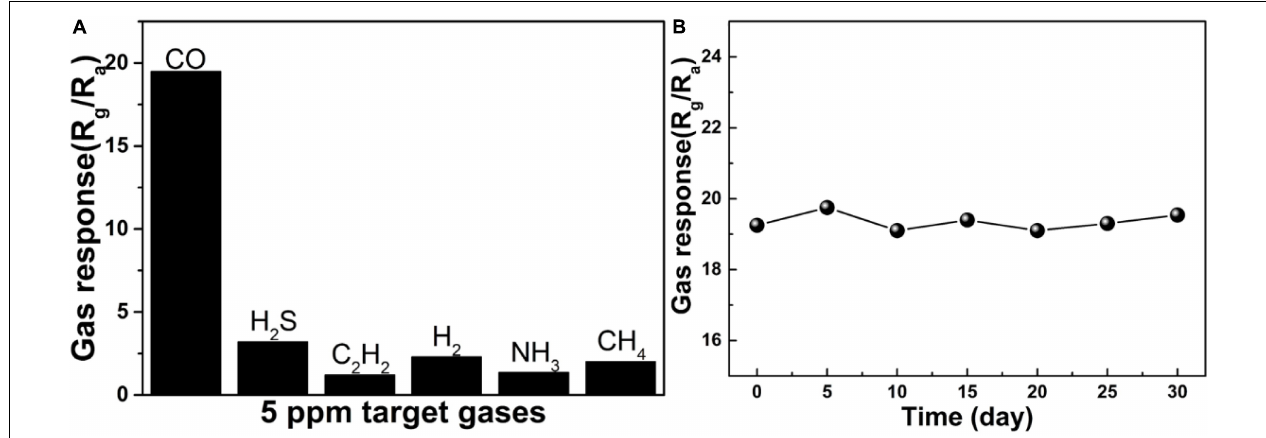
of the concentration of CO from 1 to 100 ppm. Besides, the linear fitting function and the linear correlation coefficient were calculated as y = 17.57 + 0.43x and 0.995, respectively. It can be found that the responses of flake-flower NiO based sensor increased obviously linearly with the increasing CO from 1 to 100 ppm at the optimal working temperature of 250 ◦ C. Figure 8 demonstrates the and